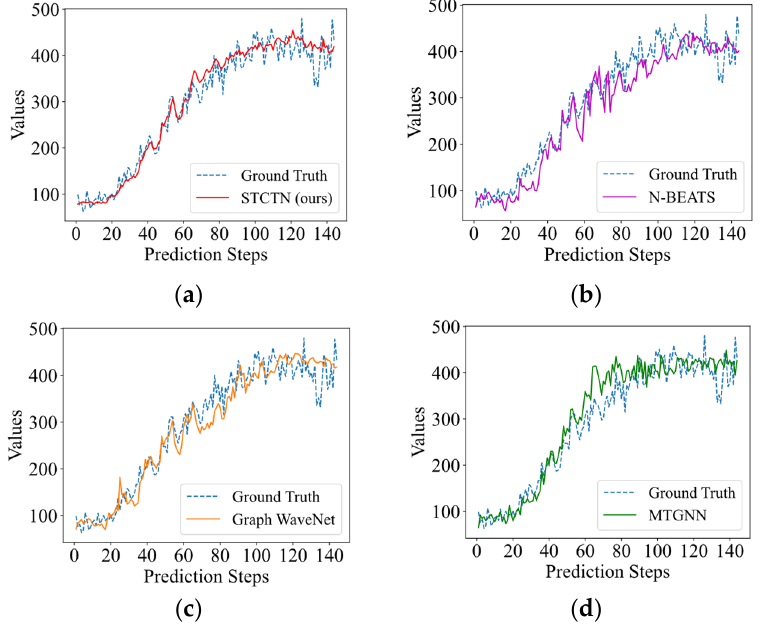
Figure 5. The long-term forecasting results (12 h, 144 steps). ( a ) STCTN (ours); ( b ) N-BEATS; ( c ) Graph WaveNet; ( d ) MTGNN.